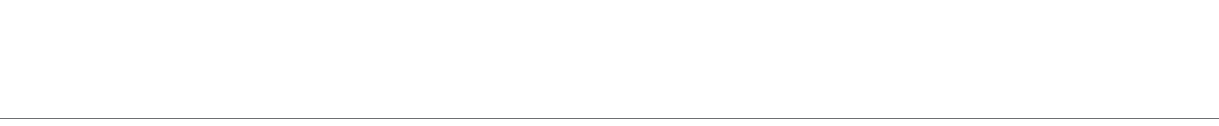
Frontiers in Energy Research |